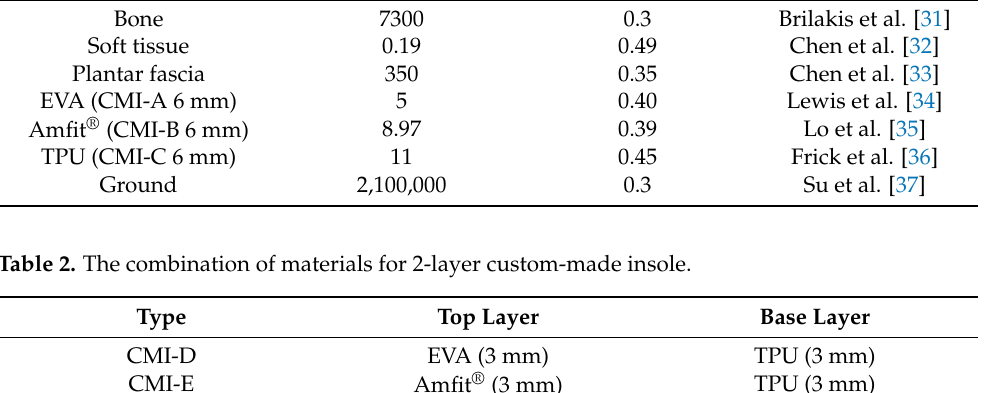
Table 1. Material properties of bone, soft tissue, plantar fascia and custom-made insole in the finite element model.